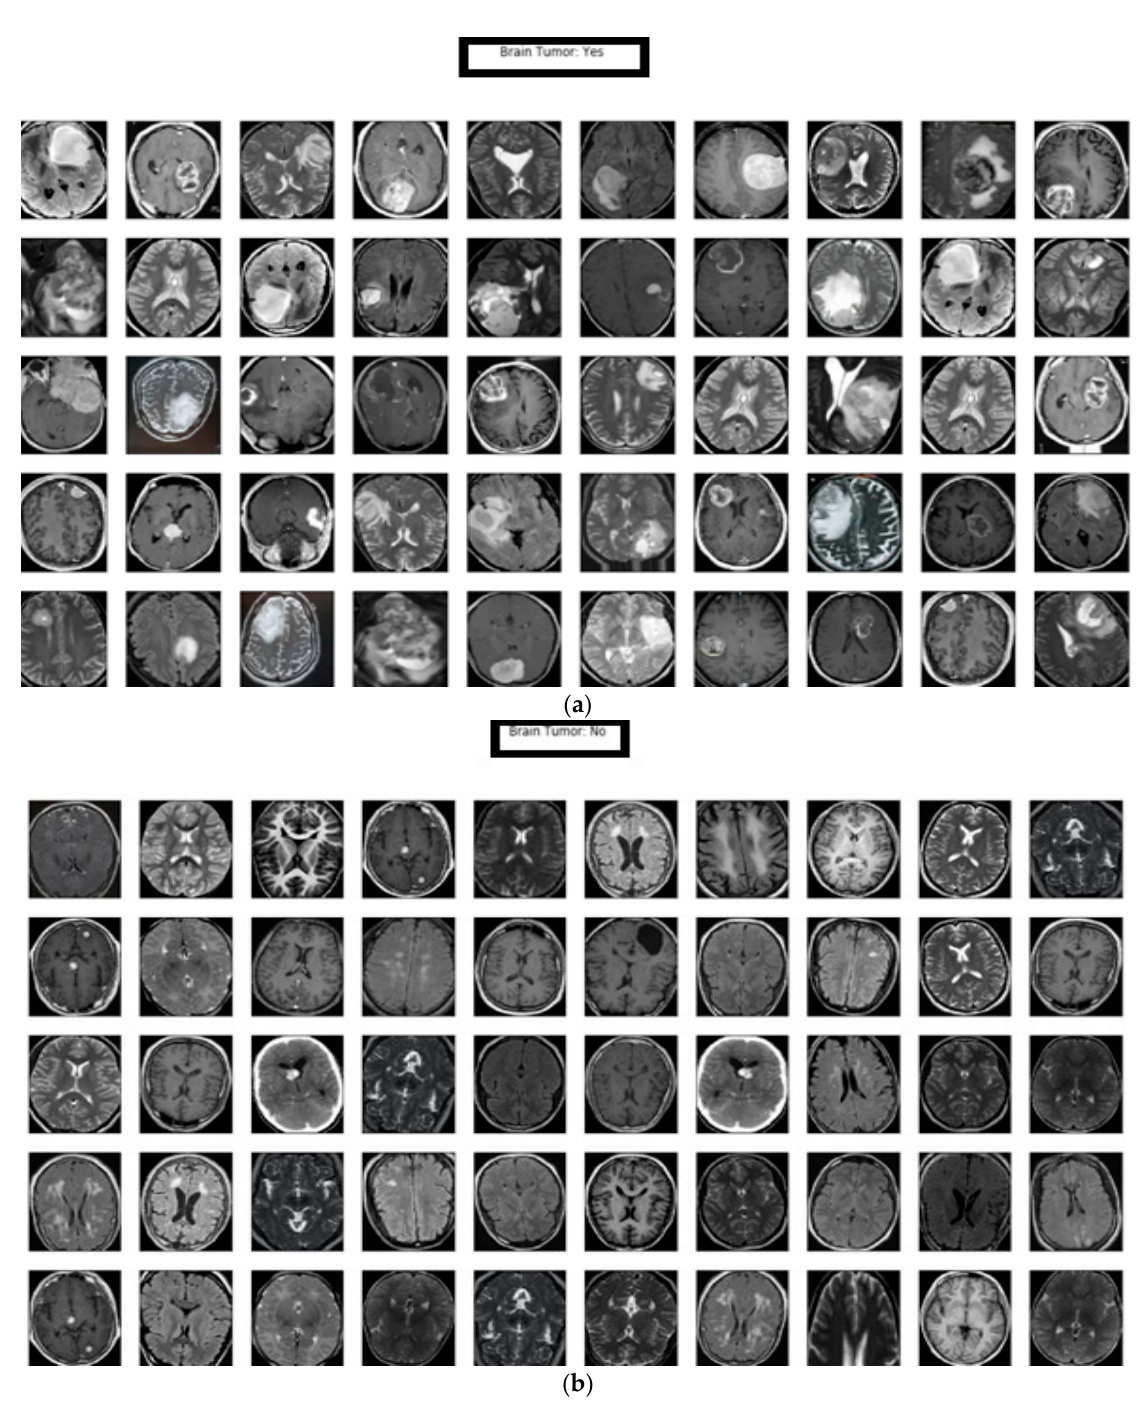
Figure 4. ( a ). Samples represent the results of abnormal T1, T2 and FLAIR MR brain images classification obtained by the differential deep ‐ CNN model and ( b ) the samples represent the results of the normal T1, T2 and FLAIR MR brain images classification achieved by the differential deep ‐ CNN model.